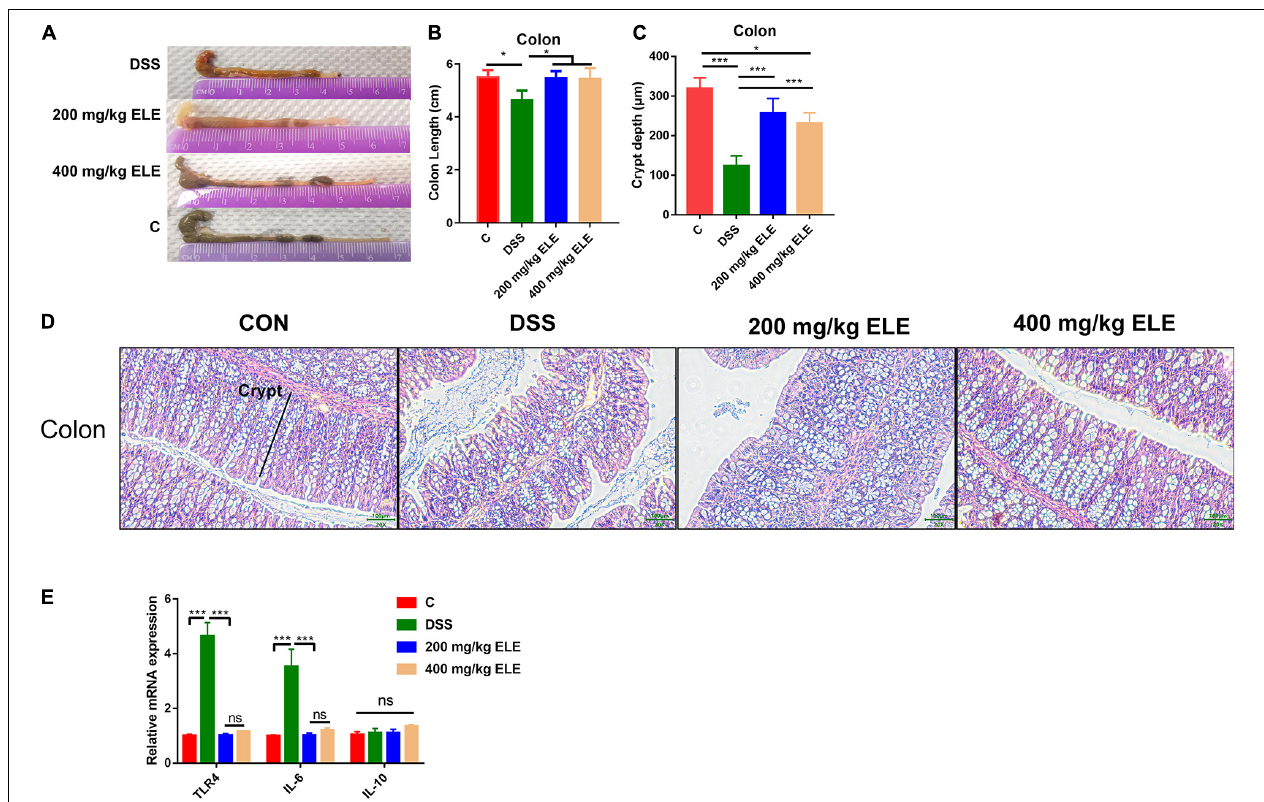
FIGURE 2 | Oral administration of ELE improved DSS induced colon length shortening and epithelial destruction. (A) Representative picture of colon length. (B) Colon length of mice in each group, n = 10–12 mice/per group. (C) The crypt depth of mice in colon, n = 6 mice/group. (D) Representative picture of colon epithelium, objective × 20, the scale indicates 100 µ m. (E) The relative mRNA expression level of Toll-like receptor 4 (TLR4), IL-6, and IL-10 in colon, n = 9–12 mice/group. Differences in data in mouse subjects were assessed by one-way ANOVA. * p < 0.05; *** p <